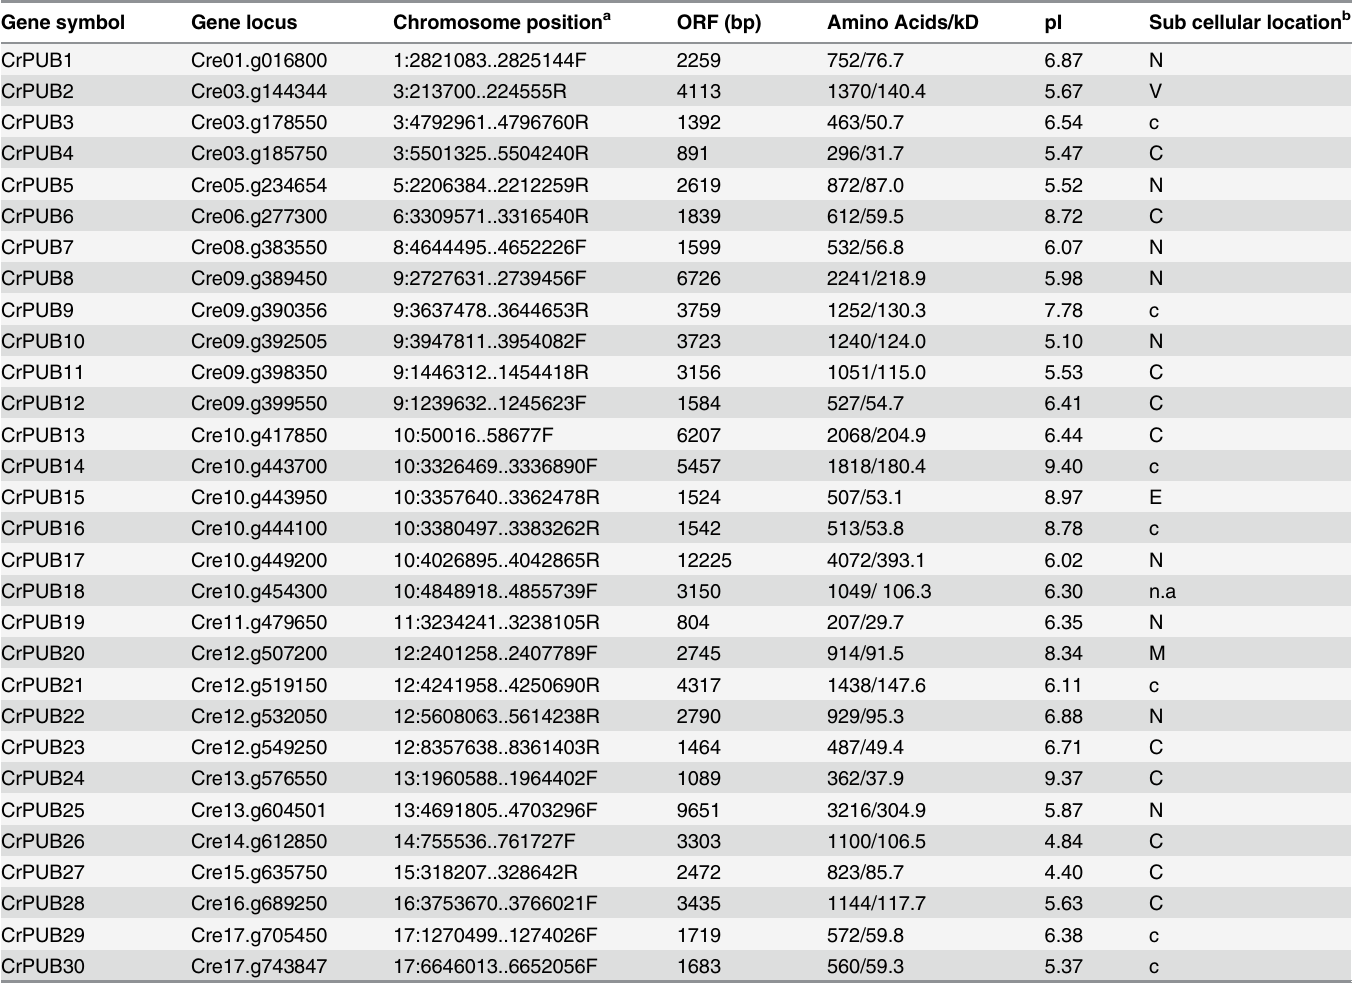
Table 2. List of the 30 U-box genes identified in C . reinhardtii and their sequence characteristics. Gene symbol Gene